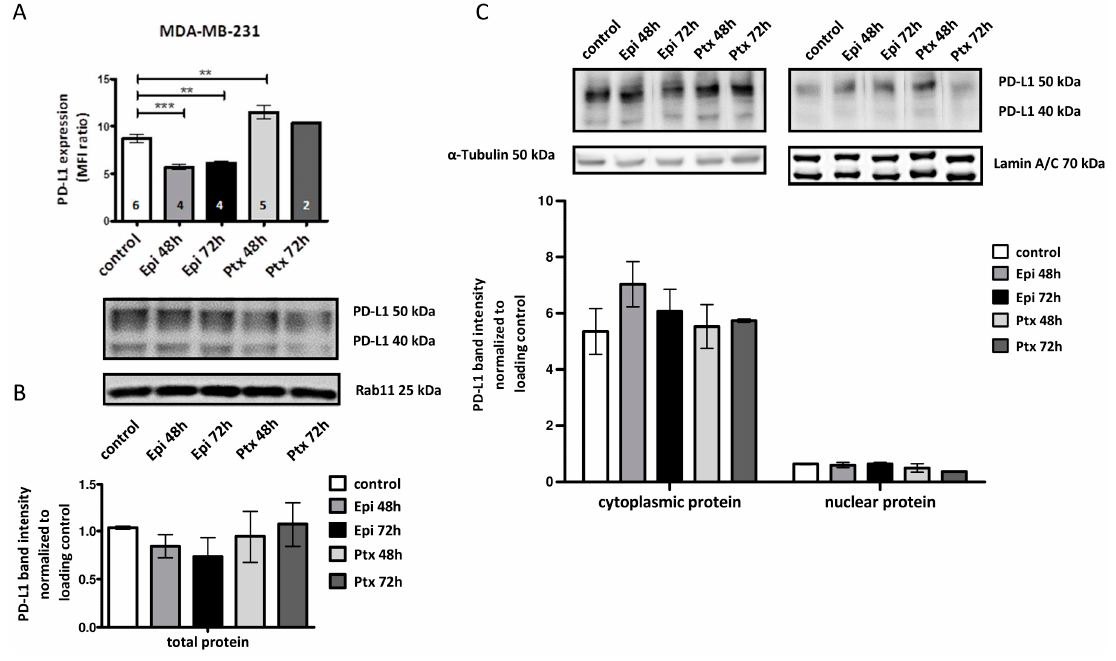
Figure 3. PD-L1 cell surface, total protein, and fractioned protein expression after cytotoxic treatment in MDA-MB-231 BC cell line. ( A ) Flow cytometric measurement of PD-L1 expression on MDA-MB-231 BC cell line after cytotoxic treatment with Epi or Ptx. Data are represented as MFI ratio = (MFI PD-L1 /MFI isotype ) ± SEM. Number of repeated measurements are shown in each bar. Significance was calculated using one-way analysis of variance (ANOVA) and Dunnett’s post-hoc test (** = p < 0.01; *** = p < 0.001); ( B ) Western blot analysis of MDA-MB-231 total protein lysates after cytotoxic treatment. Rab11 was used as loading control. Data are presented as mean ± SEM ( n = 2); ( C ) Western blot analysis of PD-L1 in cytoplasmic and nuclear protein fraction after cytotoxic treatment. Lamin A/C was used as a loading control for nuclear protein, and α -Tubulin for the cytoplasmic protein fraction. Data are represented as mean ± SEM ( n = 2). Representative western blots are provided for each dataset.